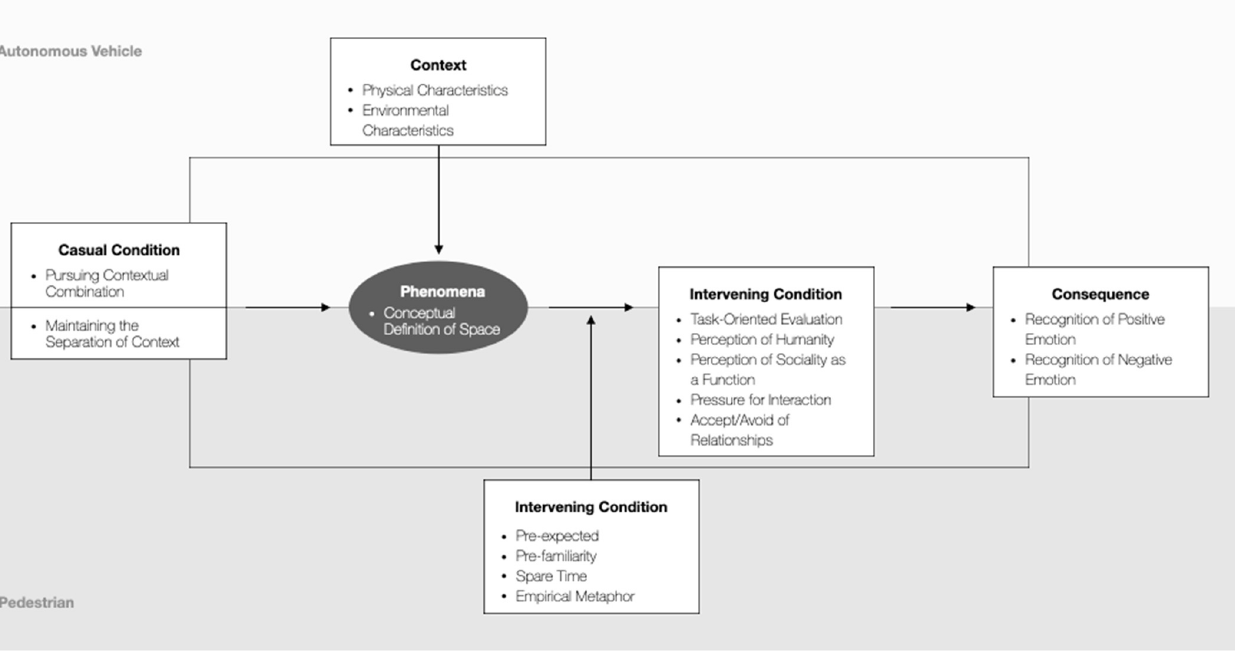
Figure 10. Conceptual model of paradigm analyses.